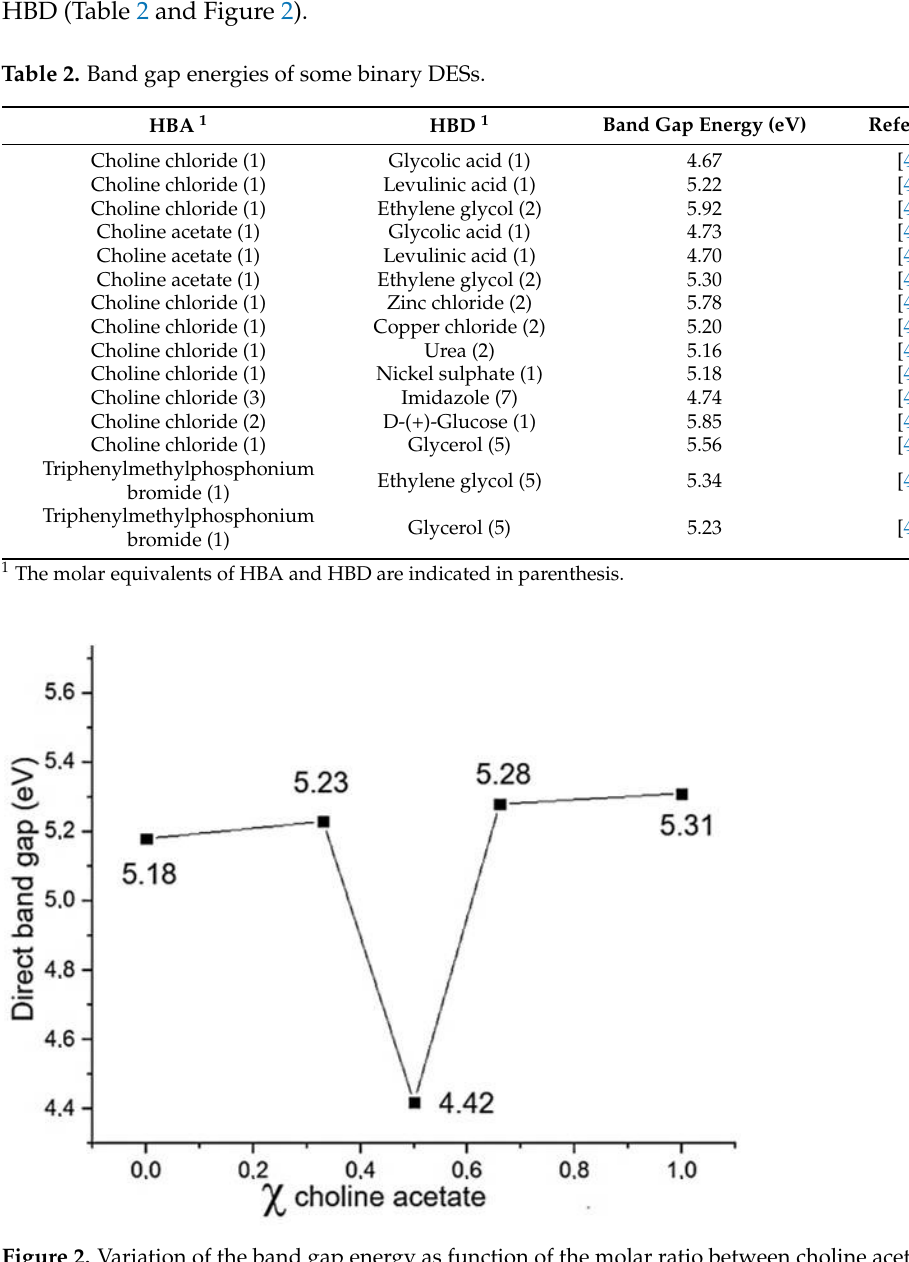
Table 2. Band gap energies of some binary DESs.